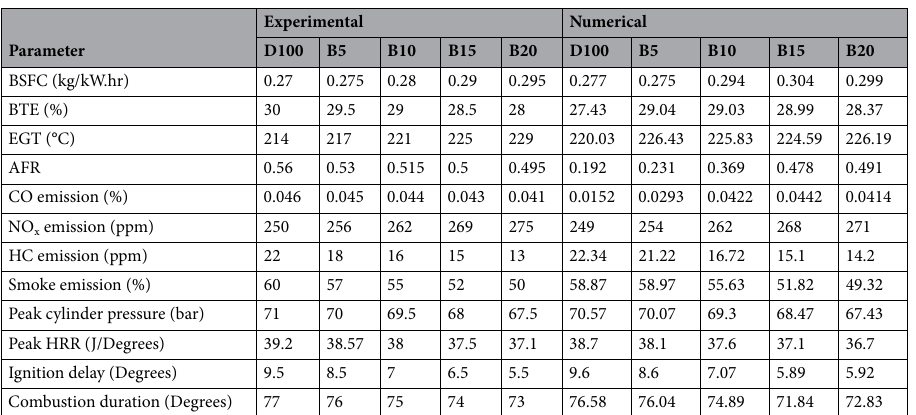
Table 4. Comparative analysis between numerical and experimental data at engine full